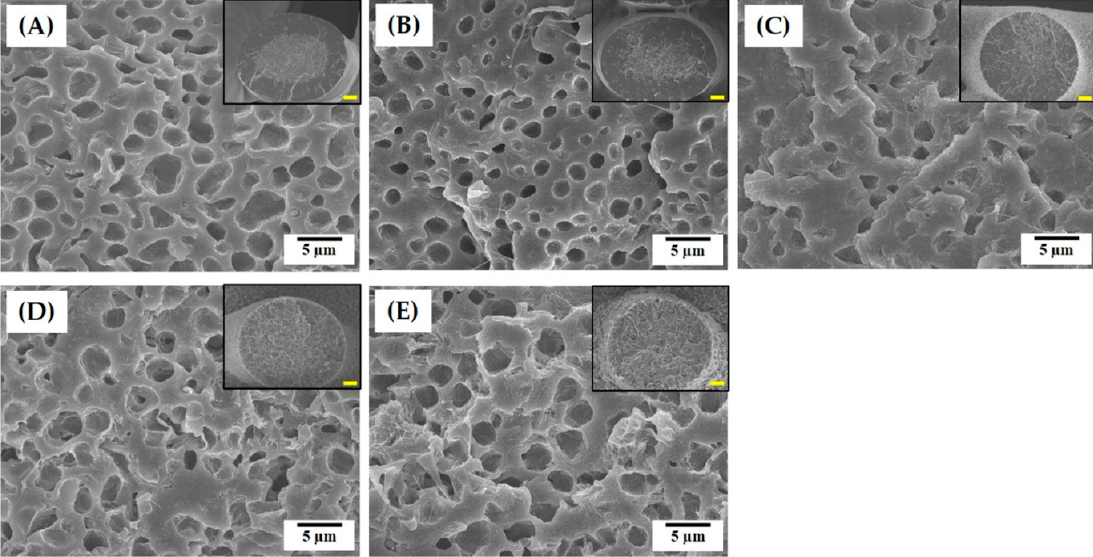
Figure 3. Representative field emission -SEM images of the microporous structures of the PCL filaments produced using various camphene contents: ( A ) 0 wt%, ( B ) 20 wt%, ( C ) 30 wt%, ( D ) 40 wt%, and ( E ) 50 wt%. Insets in Figure 3A–E show the cross-sectional morphologies of the PCL filaments.